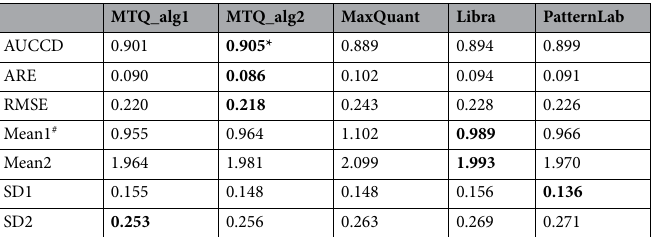
Table 2. Evaluation measures for 2023 commonly quantifiable proteins of the four software tools on Hultin- iTRAQ8. *Boldface indicates the best measure among the tools. # Since this standard data set has an ideal protein ratio of either 1 or 2, we use Mean1 and SD1 to represent mean and standard deviation of protein ratios with an ideal value of 1, and use Mean2 and SD2 to represent mean and standard deviation of protein ratios with an ideal value of